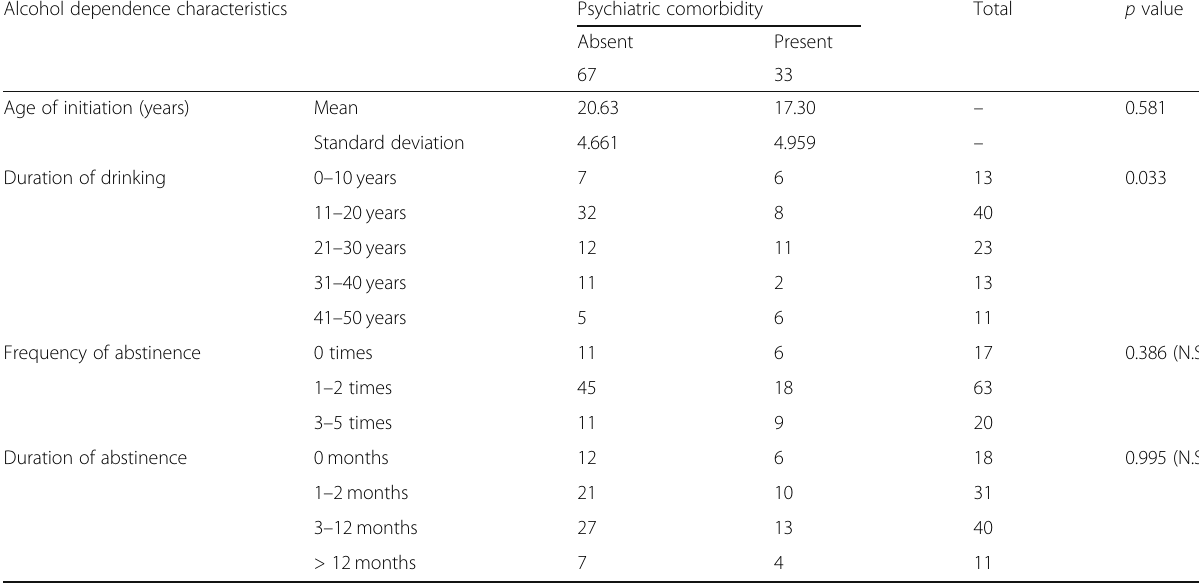
Table 5 Comparison of patients with and without psychiatric comorbidity in relation with alcohol dependence characteristics Alcohol dependence characteristics